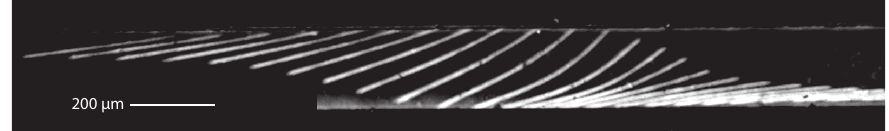
Figure 12. Chronophotography of an elastic fiber bending during the drift